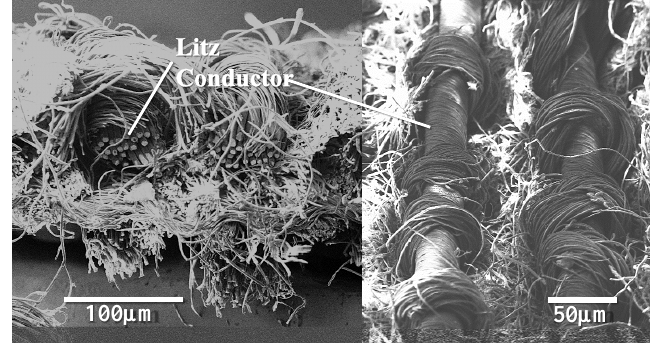
Figure 5. SEM cross-section ( Left ) and top view ( Right ) of the fabricated coil showing the conductive Litz wires embedded within the